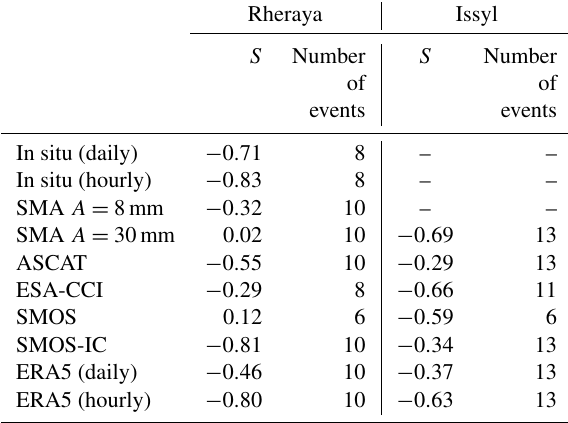
Table 7. Correlation between the different soil moisture products and the S parameter of the SCS-CN hydrological